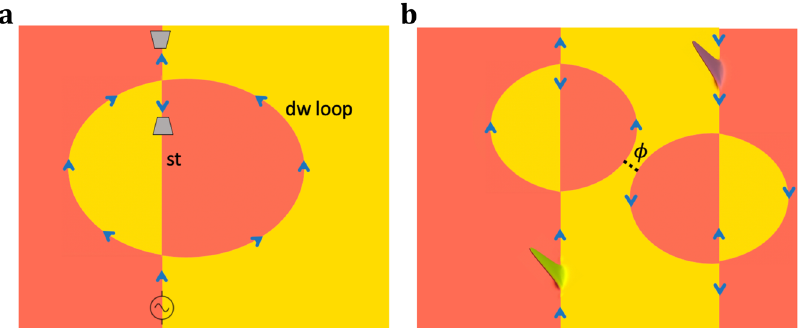
Fig. 5 Illustrations of device implementations at the surface of an antiferromagnetic topological insulator. a A Mach-Zehnder electron interferometer consisting of a domain-wall channel loop intersected by a step. Arrows show the direction of propagation while trapezoids represent detectors. b Two- qubit entanglement can be achieved by coupling two of the interferometers through the Coulomb interaction to realize a controlled phase-shift